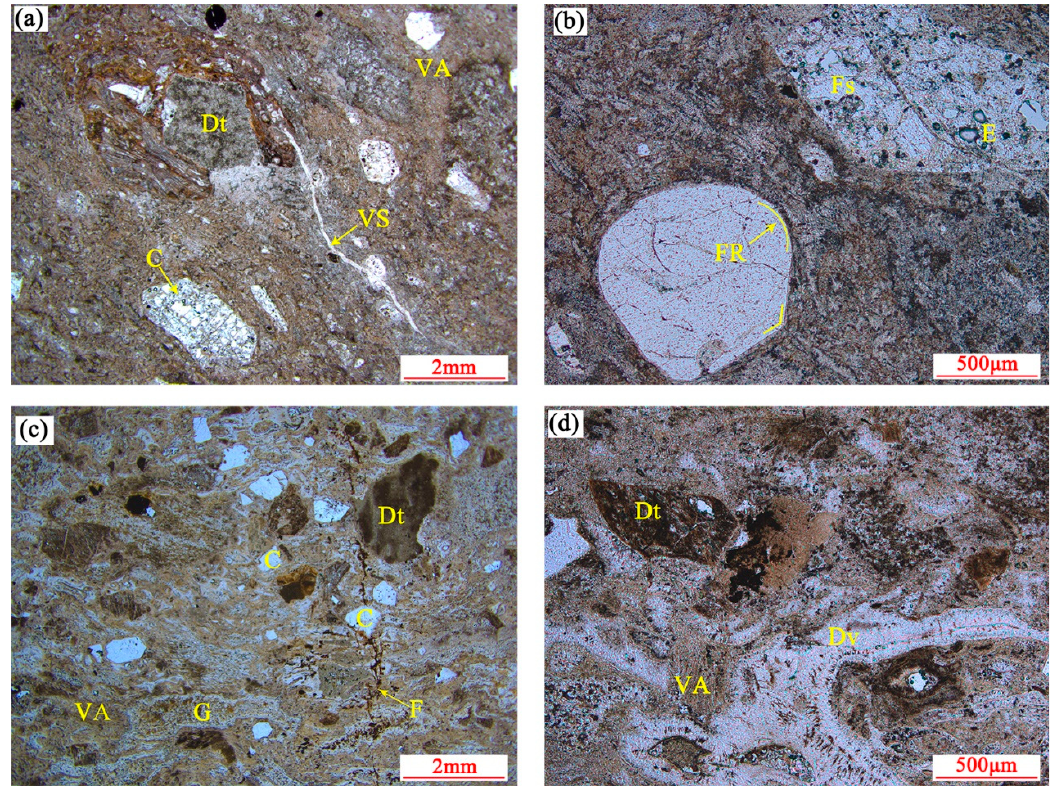
Figure 6. The plane-polarized photomicrographs of welded tuffs. ( a , b ) The strongly welded tuff. Figure 6. Plane-polarized photomicrographs of welded tuffs: ( a , b ) strongly welded tuff; ( c , d ) weakly ( c , d ) The weakly welded tuff. C: Crystal fragment, Dt: Detritus, Dv: Devitrification, E: Erosion pores, welded tuff. C: crystal fragment; Dt: detritus; Dv: devitrification; E: erosion pores; F: fissure; FR: F: Fissure, FR: Fusion rounding, Fs: Feldspar, G: Glass shards, VA: Volcanic ash, VS: Veined silica fusion rounding; Fs: feldspar; G: glass shards; VA: volcanic ash; VS: veined silica strips.